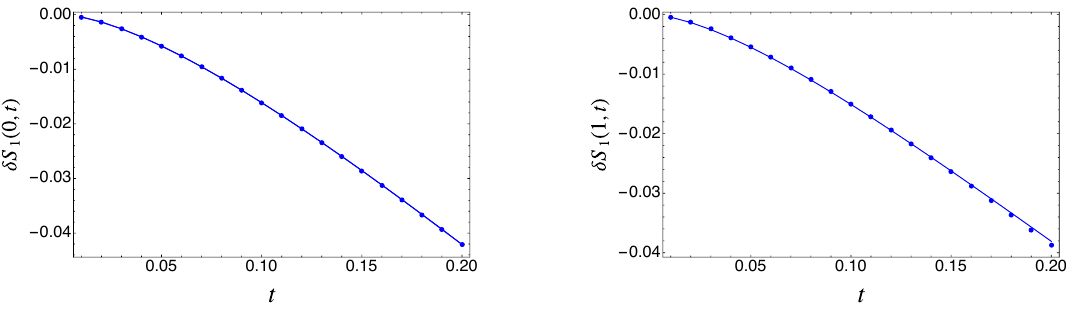
Figure 6 . Subtracted symmetry resolved von Neumann entropy (cid:14)S 1 ( q; t ) (cid:17) S 1 ( q; t ) (cid:0) S 1 ( q; t = 0) for q = 0 (left) and q = 1 (right) as a function of t ((cid:12)xing ‘ = 600 and varying m ). This subtracted quantity highlights the mass dependence of symmetry resolved entropies. The continuous lines are just the di(cid:11)erence of the same subtracted entropies as obtained from the (cid:12)eld theory expansion